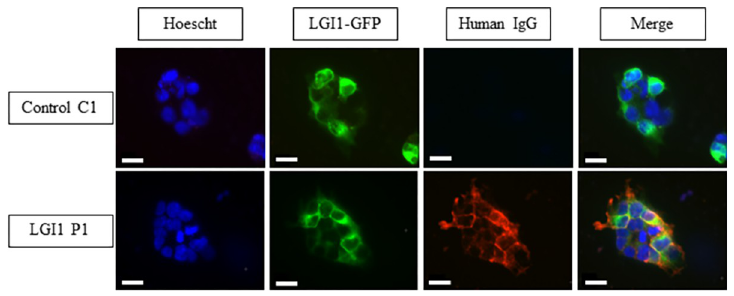
Fig 1. Purified IgG from LGI1 LE patient contain LGI1 Abs. HEK293T cells were transfected with LGI1-GFP and ADAM22 plasmids. Purified IgG from LGI1 LE patient are colocalized with LGI1-GFP signal at the cell surface of HEK293T transfected cells while no signal was found in cells treated with purified IgG from healthy subject. Scale bar = 20 μ m.